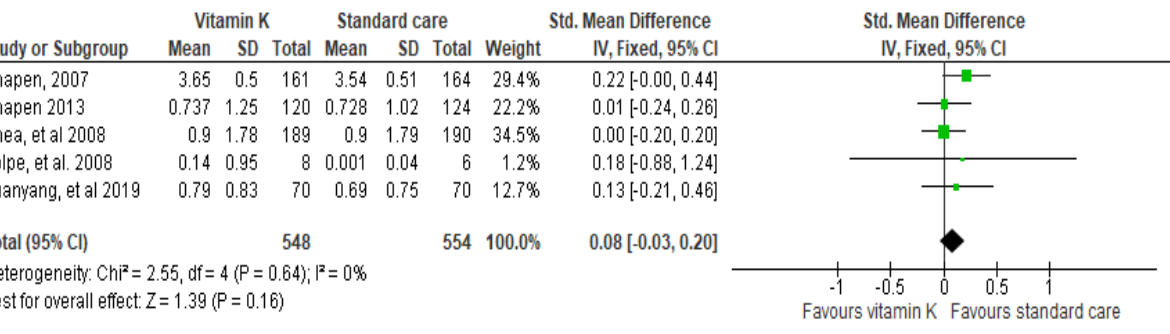
Figure 5. Forest plot: Evaluation of the VK and standard care efficacy on femoral neck BMD.